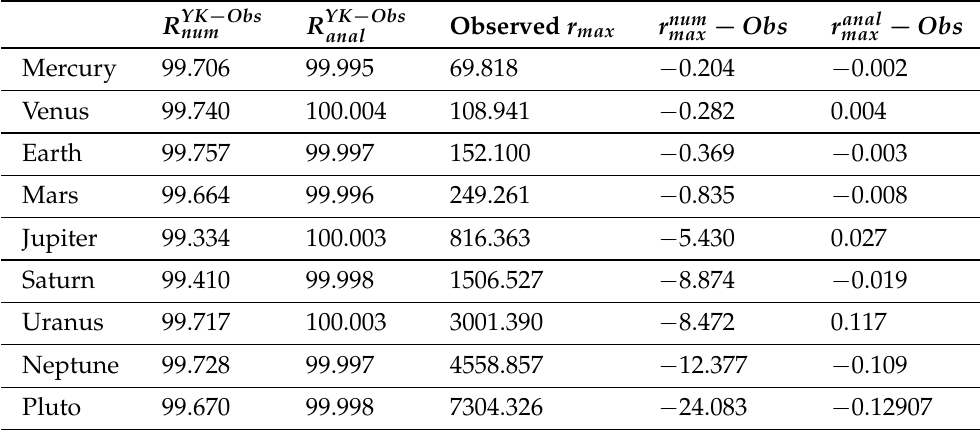
Table A21. Absolute deviation of r max from observation with estimated α , evaluated in (10 6 km).